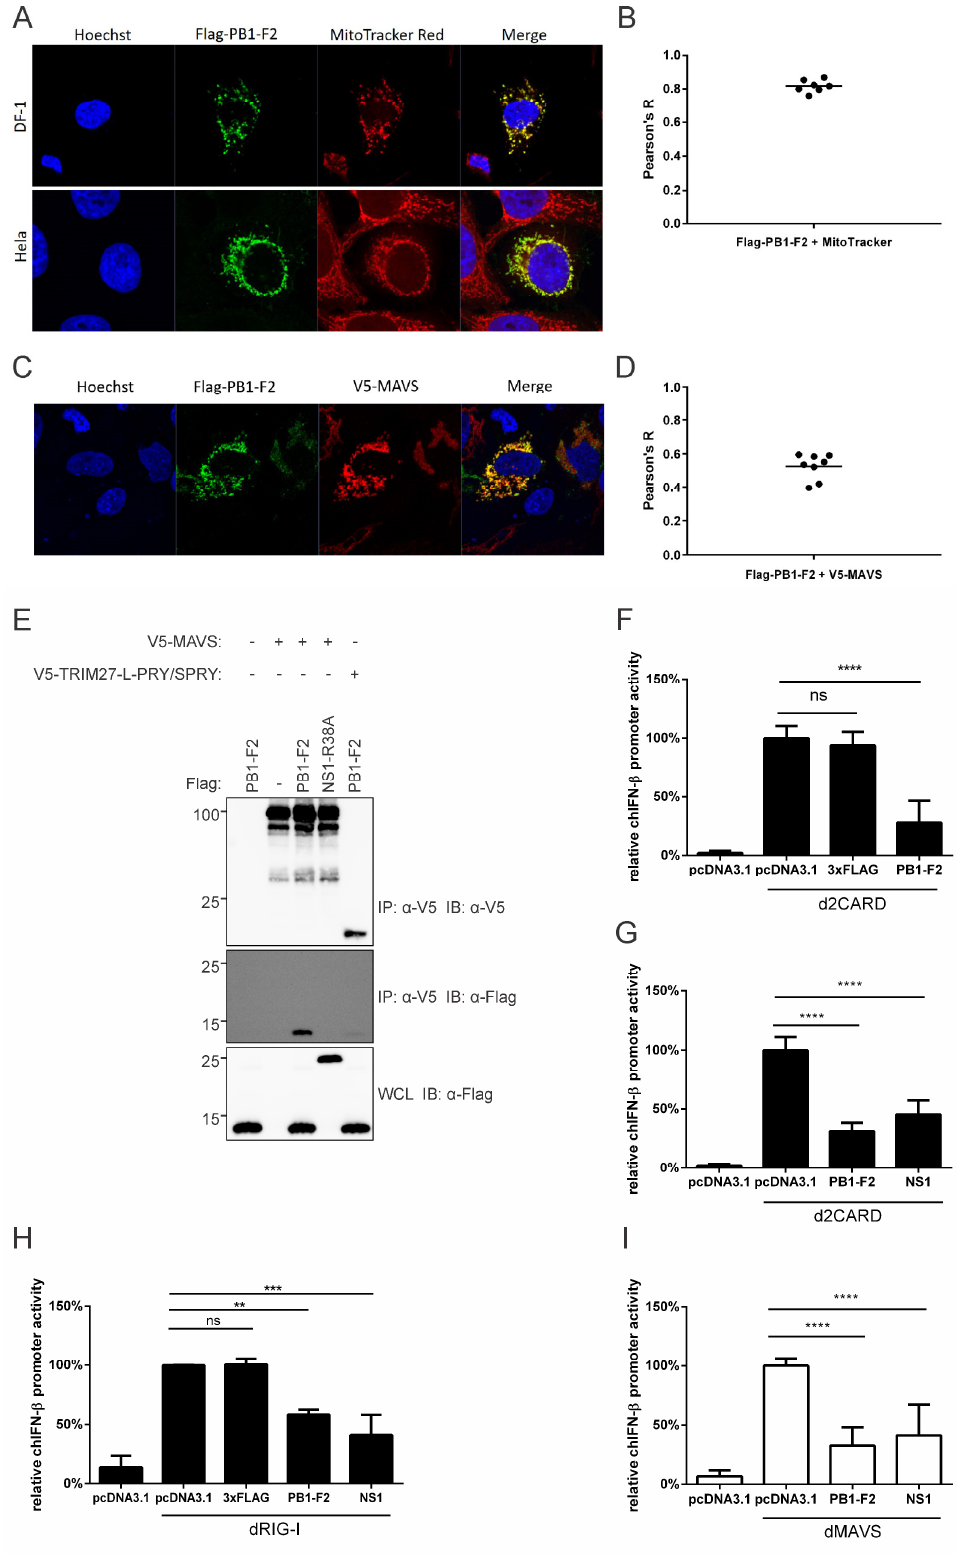
Figure 4. PB1-F2 co-localizes with MAVS and inhibits innate signaling activity in avian cells. ( A ) Mitochondrial localization of PB1-F2 in DF-1 and Hela cells overexpressing Flag-PB1-F2, stained for Flag-PB1-F2 (green) and mitochondria (red). Original magnification X1000. ( B ) Co-localization of PB1-F2 with MitoTracker in DF-1 cells was quantified using Pearson’s correlation coefficient (Pearson’s R). Bar shows mean value from seven analyzed cells. ( C ) DF-1 cells overexpressing